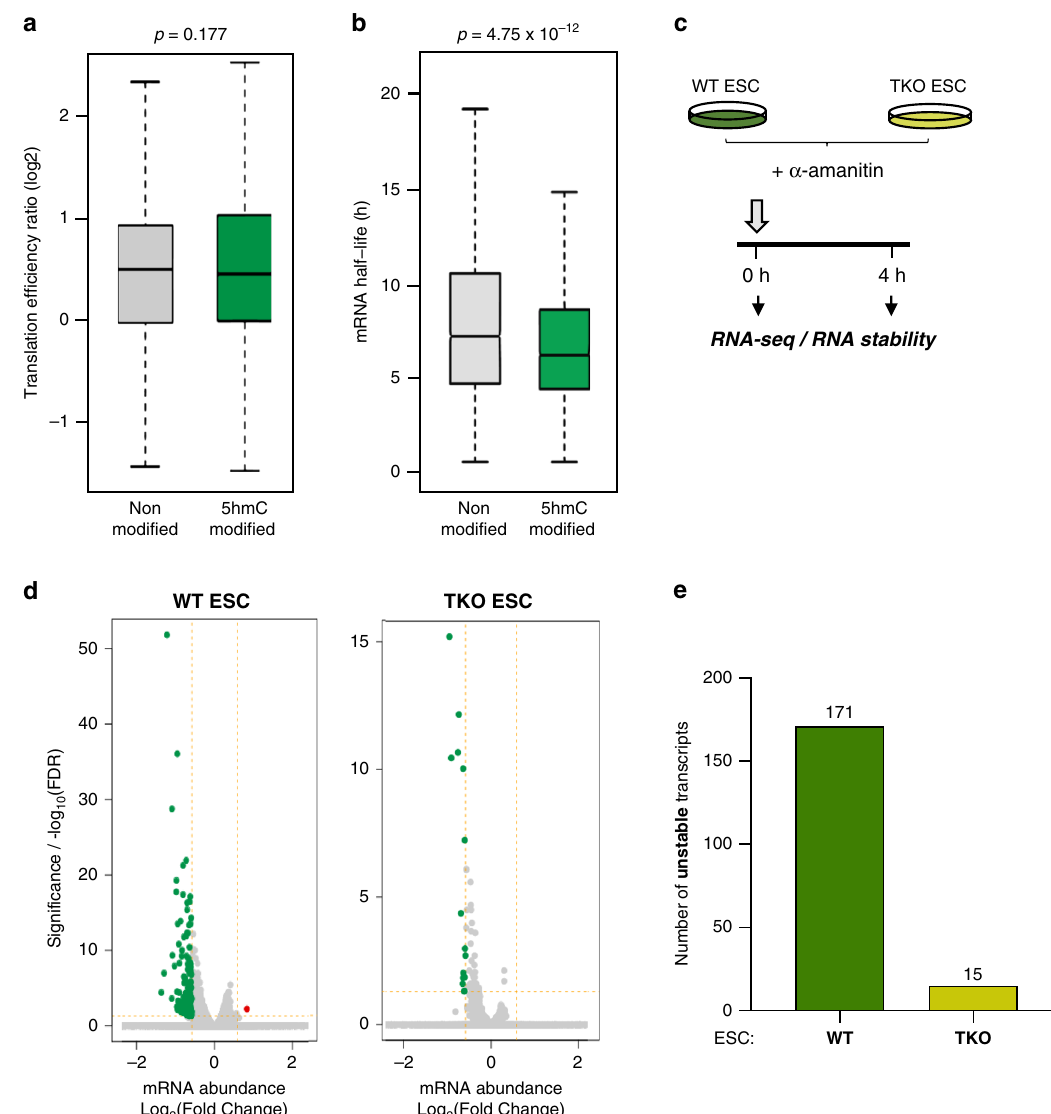
Fig. 5 Transcriptome-wide analysis of RNA stability in WT vs TKO ESCs. a 5hmC does not seem to impact mRNA translation. Box plot showing the translation ef fi ciency of non-modi fi ed and 5hmC-modi fi ed transcripts in WT ESCs using our hMeRIP-Seq data ( n = 3) and published data 39 (two-tailed Wilcoxon rank-sum test, P > 0.05). b 5hmC leads to a shorter mRNA half-life. Box plot showing the difference in mRNA half-life between non-modi fi ed and 5hmC-modi fi ed transcripts in WT ESCs using our hMeRIP-Seq data ( n = 3) and published data 40 (two-tailed Wilcoxon rank-sum test, P < 10 − 12 ). In the box plot, the boxes represent the interquartile range of the records, and the lines across the boxes indicate the median value of the records. The whiskers indicate the highest and lowest values among the records that are no more than 1.5 times greater than the interquartile range. c Scheme illustrating the protocol for transcription inhibition with α -amanitin in WT and TKO ESCs followed by RNA-Seq. Experiments were performed in biological duplicate. d Volcano plots show longer mRNA half-lives in Tet-depleted than WT ESCs. ( P -value corrected for multi-testing < 0.05 and FC > 1.5). e Bart chart showing a greater number of unstable transcripts in WT vs TKO ESCs, as determined by RNA-Seq at 0 and 4 h post α -amanitin